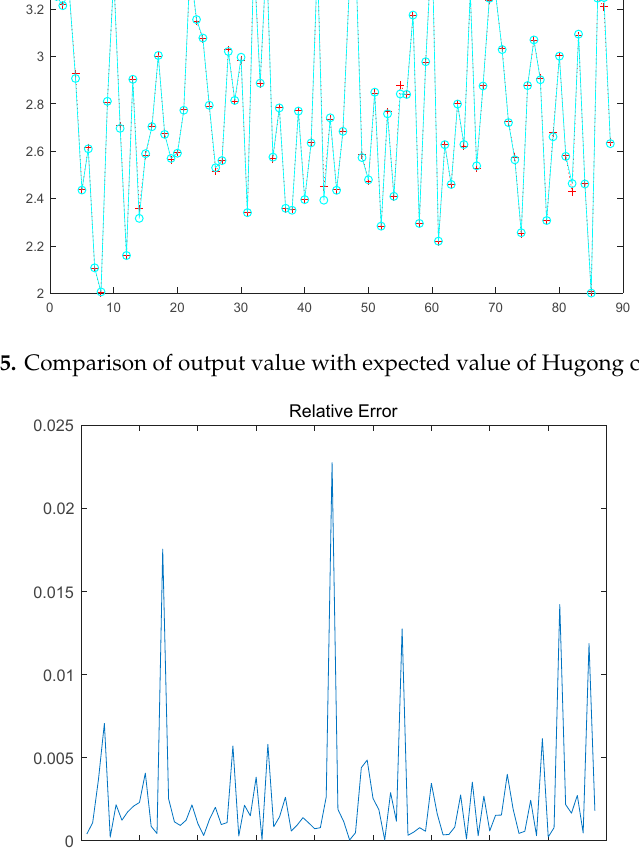
Figure A6. Relative error variation of Hugong community.